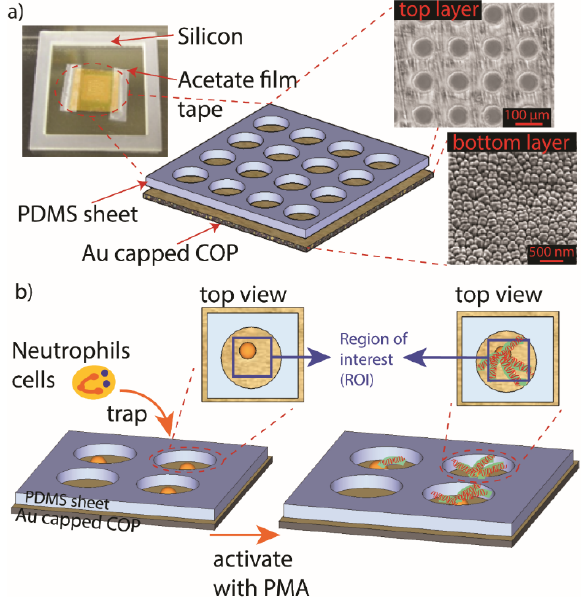
Figure 2. Full assembly of MWA plasmon chip. ( a ) (left) Perforated PDMS sheet with size of 7 mm × 7 mm was placed on 1 cm × 1 cm localized surface plasmon resonance (LSPR) sensing gold capped cyclo-olefin polymer (COP) substrate; (right) top view of MWA plasmon chip with well diameter of 60 µ m. Bottom of the microwells has nanopillar structures. ( b ) Neutrophils cells are trapped into microwell array before stimulated with phorbol 12-myristate 13-acetate (PMA) solution. Released neutrophil extracellular traps (NETs) are observed using LSRP sensing